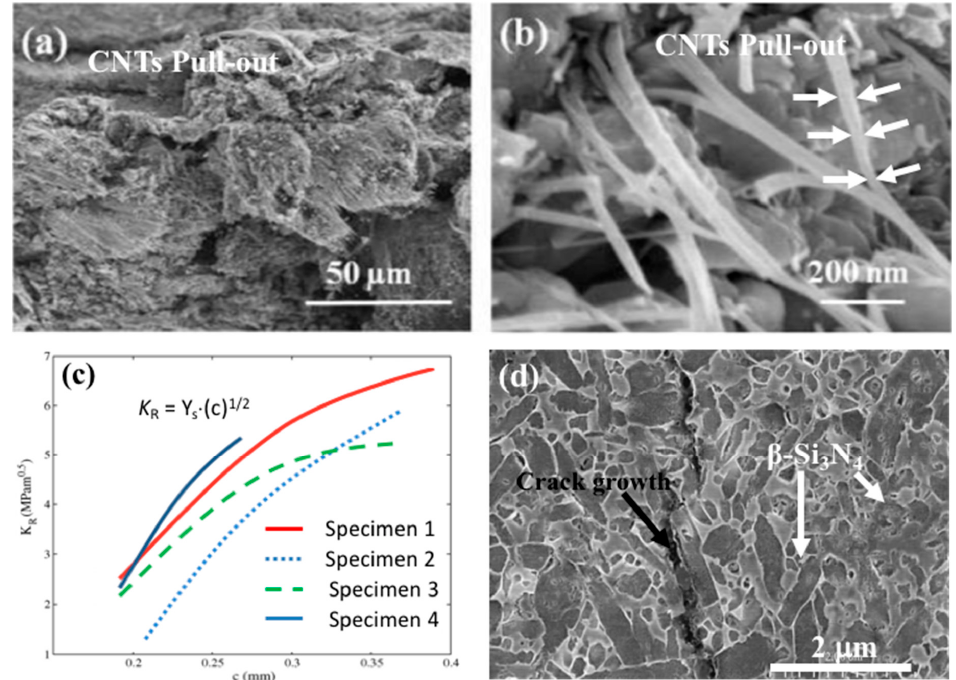
Figure 10. Toughening mechanism in Si 3 N 4 + CNT composites. ( a ) SEM image of fractured surface of Si 3 N 4 + CNTs [61]; ( b ) enlarged SEM image of ( a ) revealing the CNTs pulling out from Si 3 N 4 ceramics, the diameter of CNTs also decreased due to the pulling out and this is an example of good bonding between CNTs and grains [61]; ( c ) crack growth resistance as a function of crack length “c” in CNT-reinforced silicon nitride composites [44]; ( d ) crack propagation is visible in a Si 3 N 4 + CNT composite [44]. Reproduced from Refs. 44 and 61 with permission from